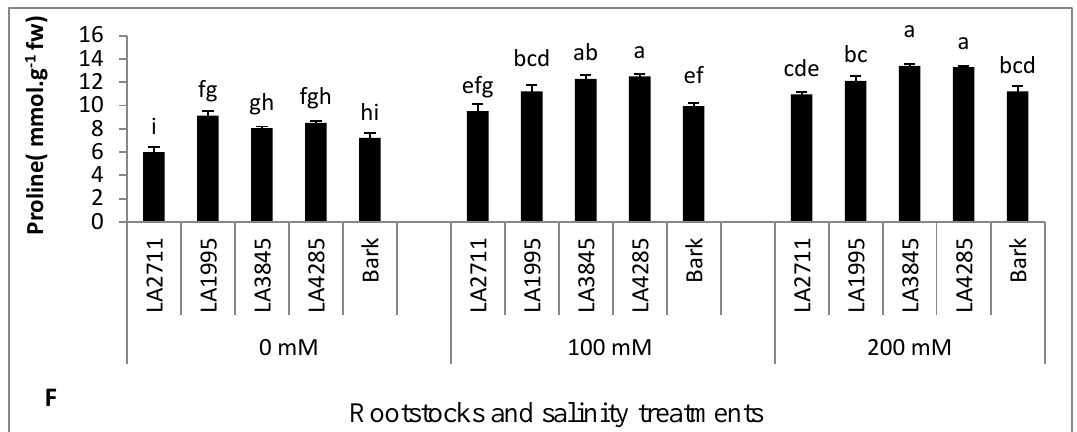
Figure 8. Effect of salinity levels × rootstocks interaction on ( A ) GA3, ( B ) ABA, ( C ) APX, ( D ) POD, ( E ) DHAR and ( F ) proline. Vertical bars represent standard errors of means ( n = 3); in each bar, values followed by different letters differ significantly at p = 0.05 according to Tukey test.